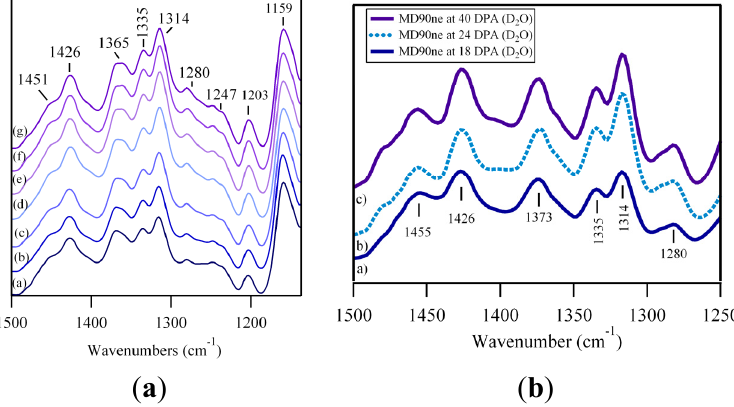
Figure 5. ( a ) FTIR spectra of the fingerprint region for cotton fibers harvested at different DPA: (a) 18 DPA; (b) 20 DPA; ( c ) 24 DPA; (d) 28 DPA; (e) 32 DPA; (f) 36 DPA; and (g) 40 DPA; ( b ) Spectra of the fingerprint region of cotton fibers treated with D 2 O and harvested at different DPA: (a) 18 DPA (bottom); (b) 24 DPA (middle); and (g) 40 DPA